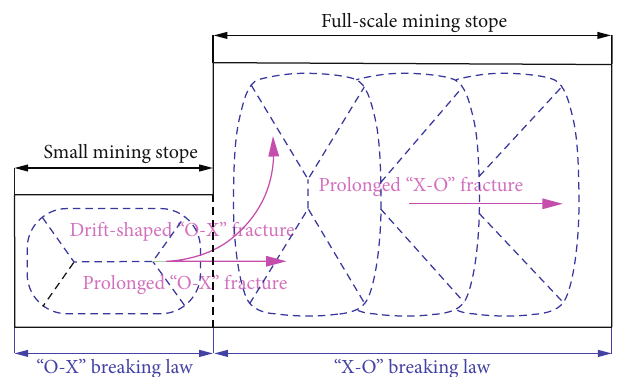
Figure 31: “ Two stopes and two laws ” roof fracture theoretical